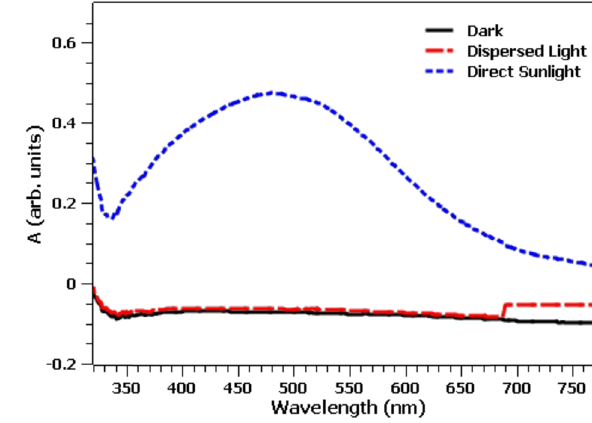
Figure 4: UV - Vis spectra of the solution mixture for di ff erent exposure times.